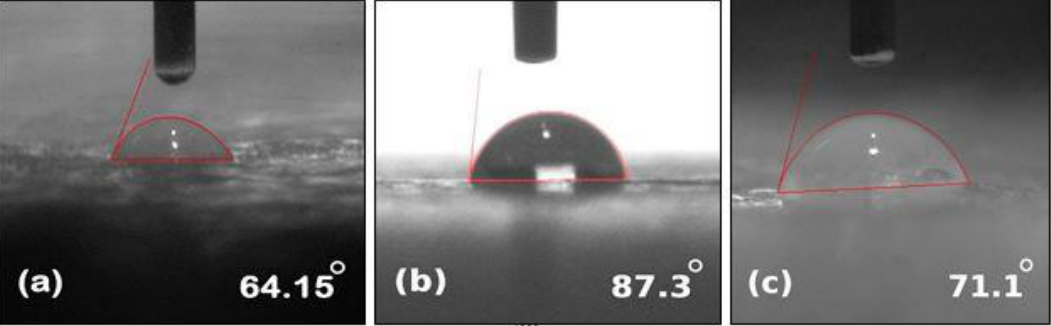
Figure 6. Measurement of contact angle of 30 h aged ( a ) neat epoxy ( b ) epoxy microcomposite, and ( c ) epoxy nanocomposite.